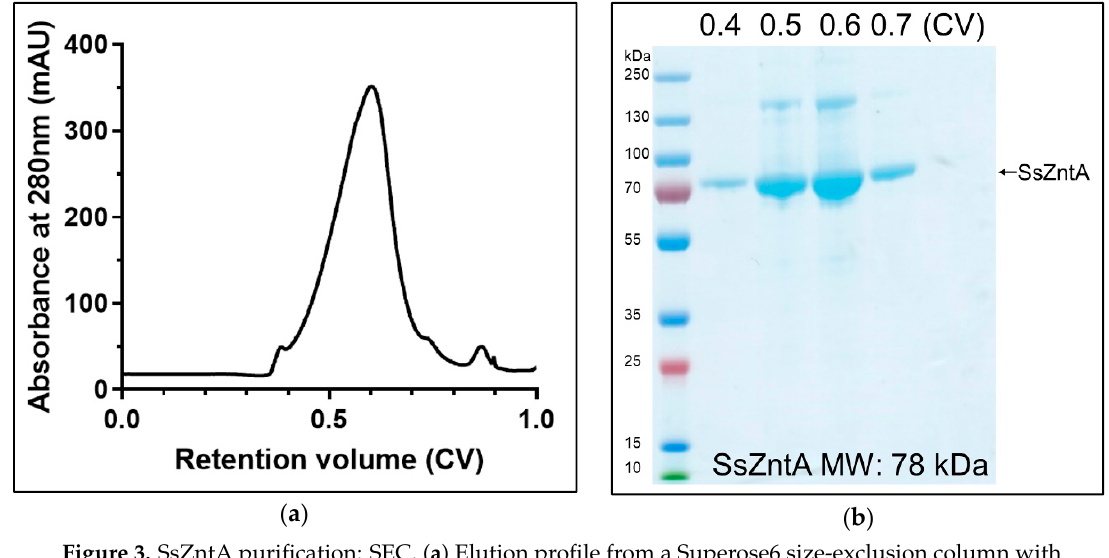
Figure 3. SsZntA purification: SEC. ( a ) Elution profile from a Superose6 size-exclusion column with a column volume (CV) = 24 mL: The main peak elutes at 0.6 CV, followed by minor contaminants. ( b ) Coomassie-stained SDS-PAGE containing the SEC fractions collected at 0.4, 0.5, 0.6, 0.7 CV; upper band at 150 kDa is possibly SsZntA dimers (due to SDS artifacts).